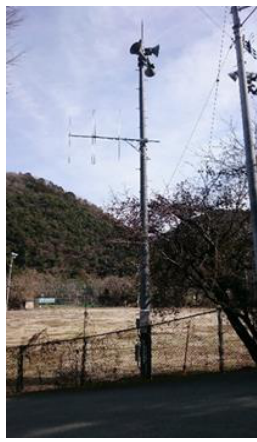
Figure 6. Loudspeaker of the DRS (Seiyo) (Ozu).